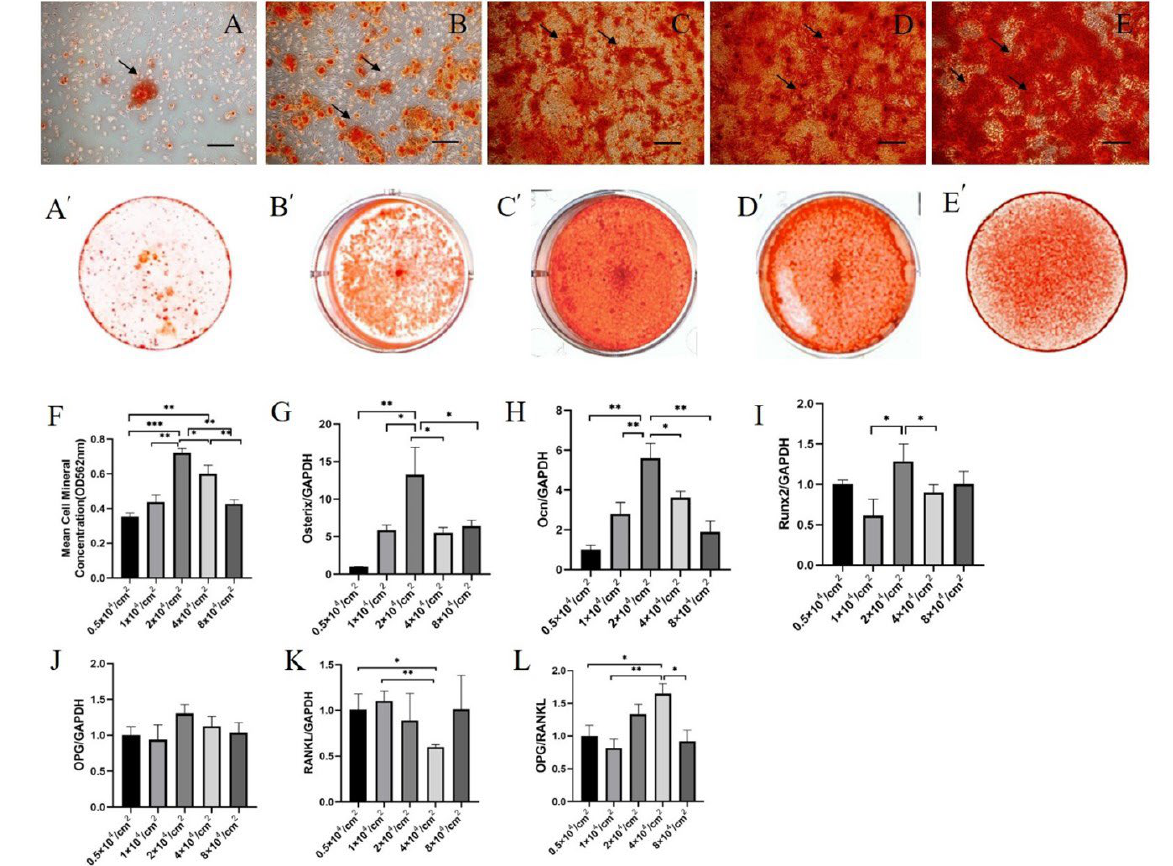
Figure 5. Osteogenesis induction effect over 14 days on hBMSCs by hPDLSC exosomes of different initial cell culture densities. Calcium nodules produced by different hPDLSC culture densities produced exosomes that induced osteogenesis for hBMSCs and were observed under light microscope. The black arrows represent calcium nodules ( A – E ). Overview of osteogenesis induction of hBMSCs by hPDLSC culture-derived exosomes from different initial cell culture densities ( A’ – E’ ). The calcium concentration of hBMSC osteogenesis induced by exosomes from the 2 × 10 4 /cm 2 hPDLSC culture was the highest ( F ). Expressions of osterix, OCN, RUNX2, OPG, and RANKL and the OPG/RANKL ratio in the 2 × 10 4 /cm 2 group ( G – L ). * indicates p < 0.05, ** indicates p < 0.01, *** indicates p < 0.001 ; scale bar = 50 µm.